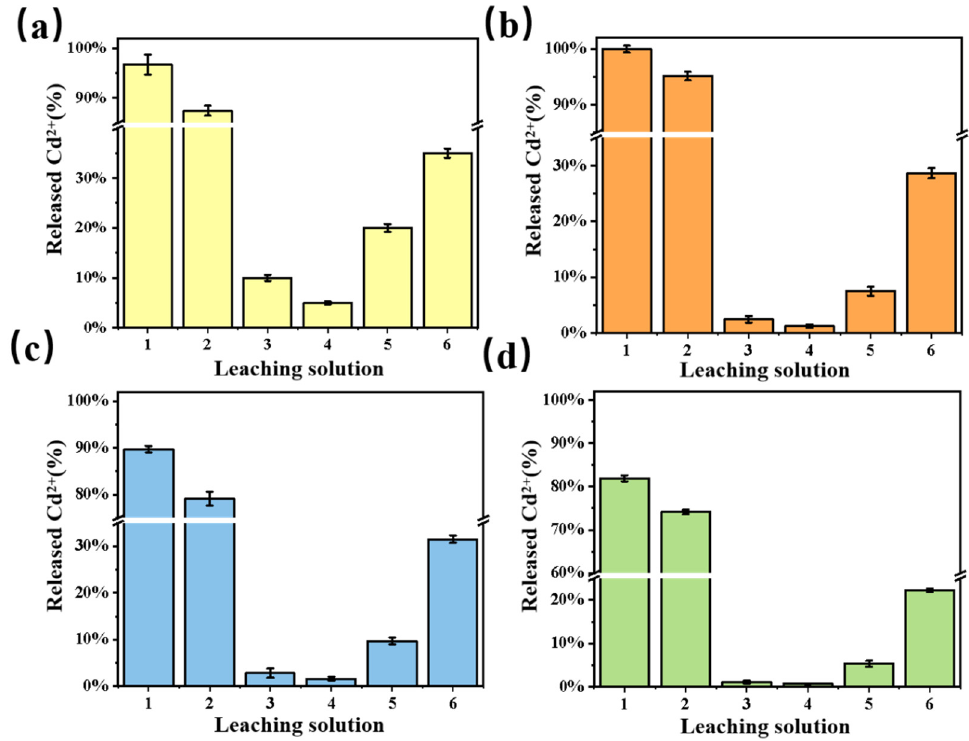
Figure 9. Relative percentage of Cd 2+ ions desorbed from BC and BCH samples: RB ( a ), BC-300 ( b ), BCH ( c ), BCH-300 ( d ). Leaching solutions: (1) pH 1, (2) pH 2, (3) pH 4, (4) pH 6, (5) 25 mmol/L Ca(NO 3 ) 2 and (6) 100 mmol/L Ca(NO 3 ) 2 .